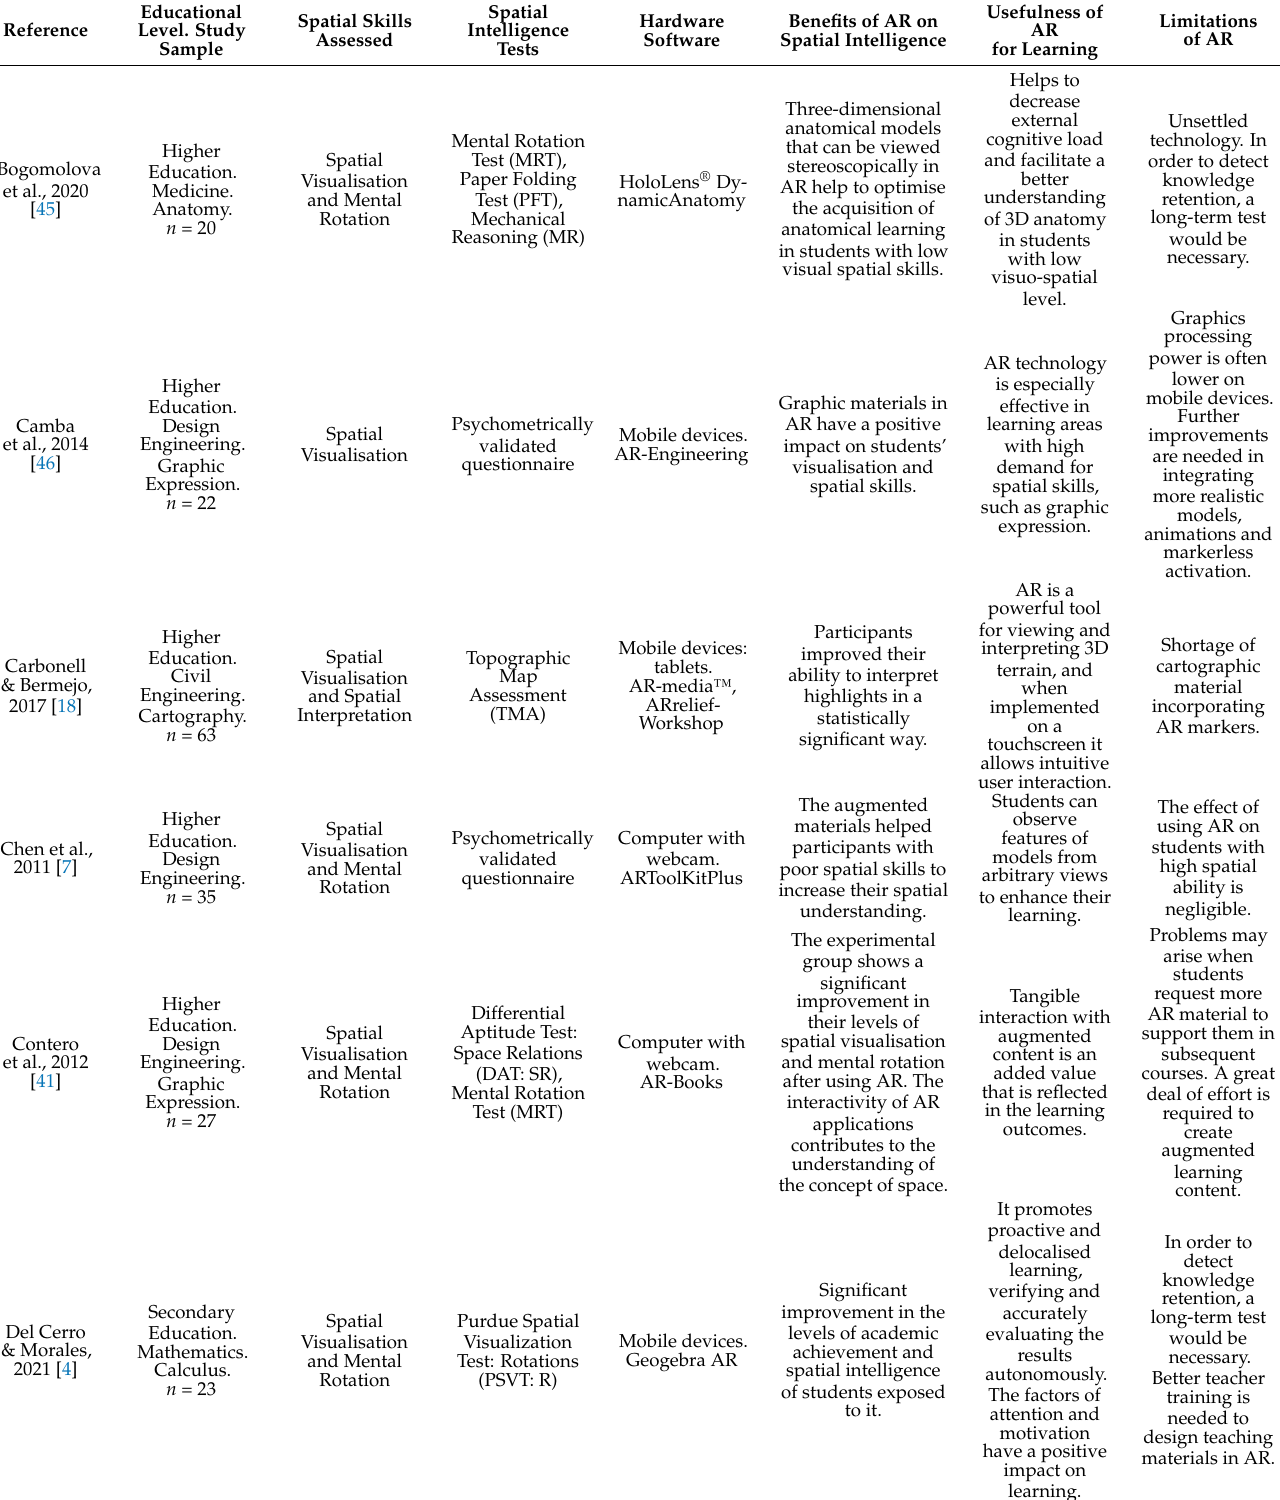
Table 5. Evaluation Summary of key findings from selected